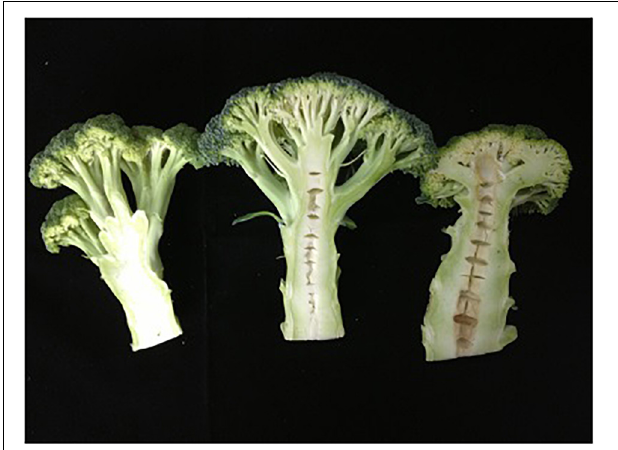
FIGURE 1 | Stem longitudinal sections of maternal line (Right) , paternal line (Left) , and F 1 hybrid (Middle) of